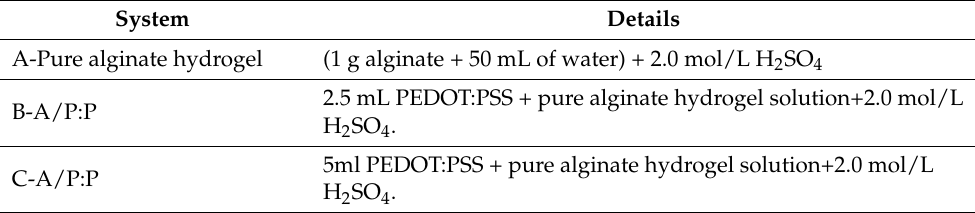
Figure 13. Preparation of ( A ) pure alginate and ( B , C ) alginate/PEDOT:PSS (A/P:P) hydrogel electrolytes. Table 4. Details of the A/P:P with respect to the PEDOT:PSS ratio. System